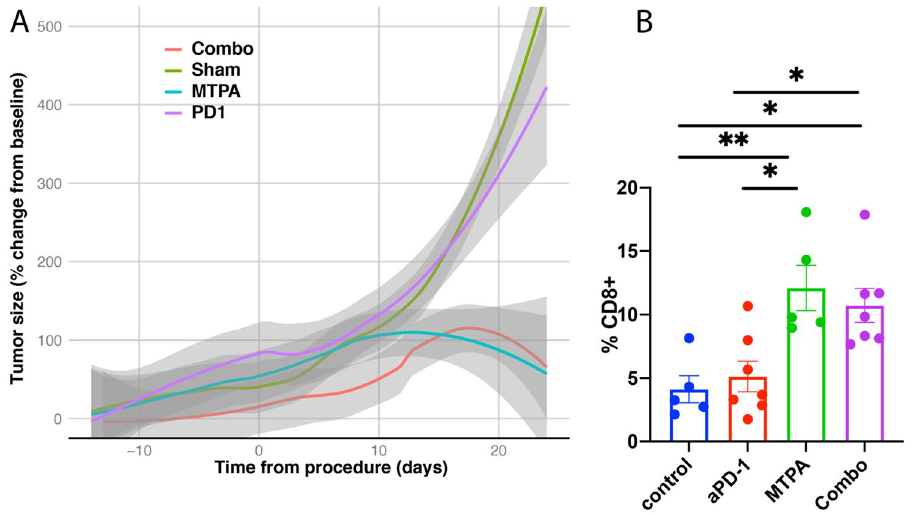
Figure 6. Growth response of remote tumors following MTPA to orthotopic HCC tumors. ( A ) Remote tumors demonstrated continued growth following sham surgery (control arm, n = 15) or anti-PD-1 therapy (n = 12). However, there was inhibition of remote tumor growth following MTPA treatment to the orthotopic liver tumor (n = 12) and in the combination MTPA+anti-PD-1 therapy (n = 12), though there was no difference identified between the MTPA alone versus the combination arm. ( B ) Immunohistochemical analysis demonstrated a significant increase in infiltrating CD8+ T cells within the subcutaneous tumors when the orthotopic liver tumor was treated with MTPA and MTPA+anti-PD-1 therapy relative to sham surgery and anti-PD-1 therapy alone (* P < 0.05; ** P < 0.01). Percentages in panel B reflect the proportion of positively stained cells within a region of interest circumscribing the tumor. Box plots reflect mean +/− standard error. The non-parametric Mann– Whitney U-test was used to evaluate differences in the proportions across treatment